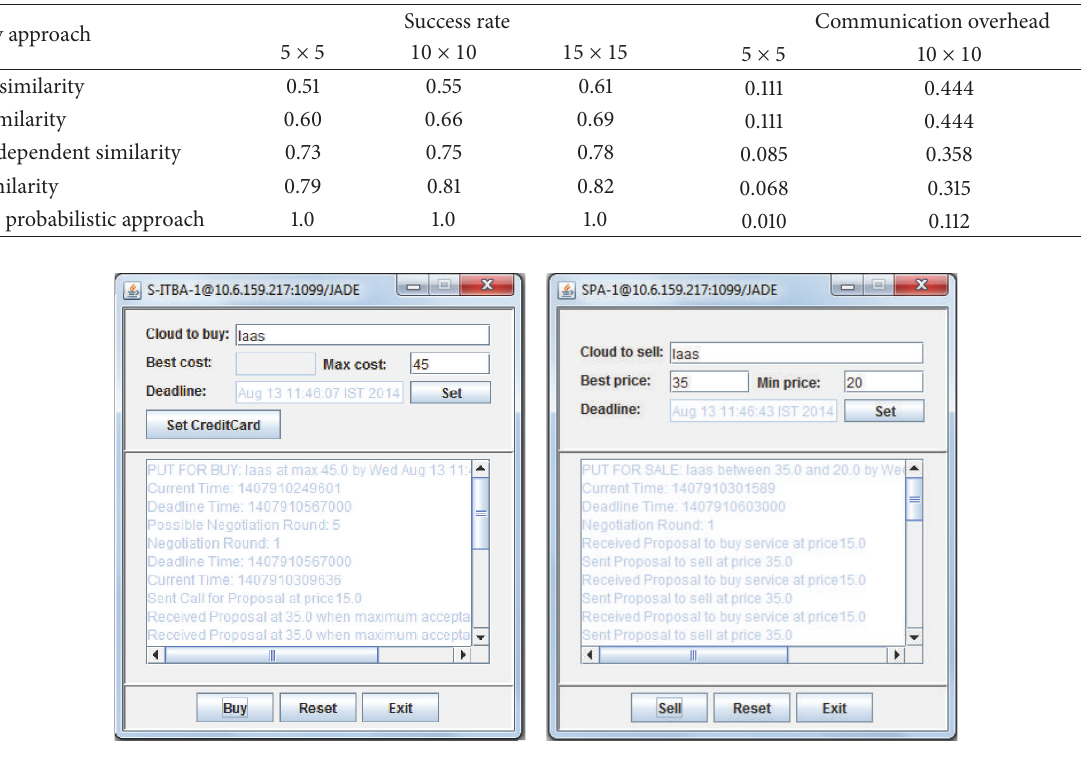
Table 2: Experimental results of different negotiation pairs of combination.